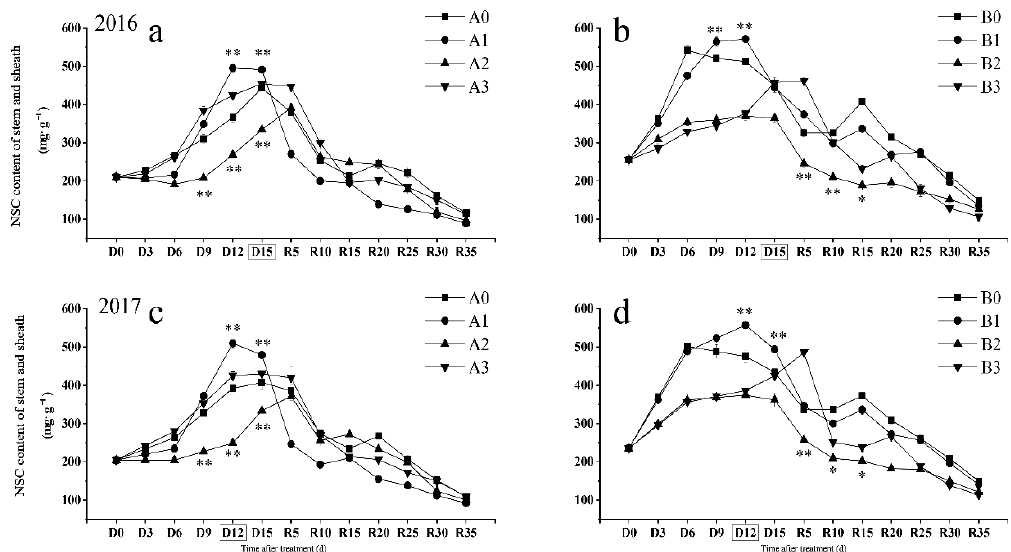
Figure 1. Effects of drought stress at the jointing–booting stage on NSC content in growth period overlapping rice in 2016 ( a , b ) and 2017 ( c , d ). The full heading stage was D15 days in 2016 and D12 days in 2017. Vertical bars represent standard deviation. A0 and B0, control treatments (0 kPa) of SJ6 and DN425; A1 and B1, mild drought stress treatments (-10 kPa); A2 and B2, mild drought stress treatments (-25 kPa); A3 and B3, severe drought stress (-40 kPa). *, ** represent significance at p < 0.05 and p < 0.01, respectively.